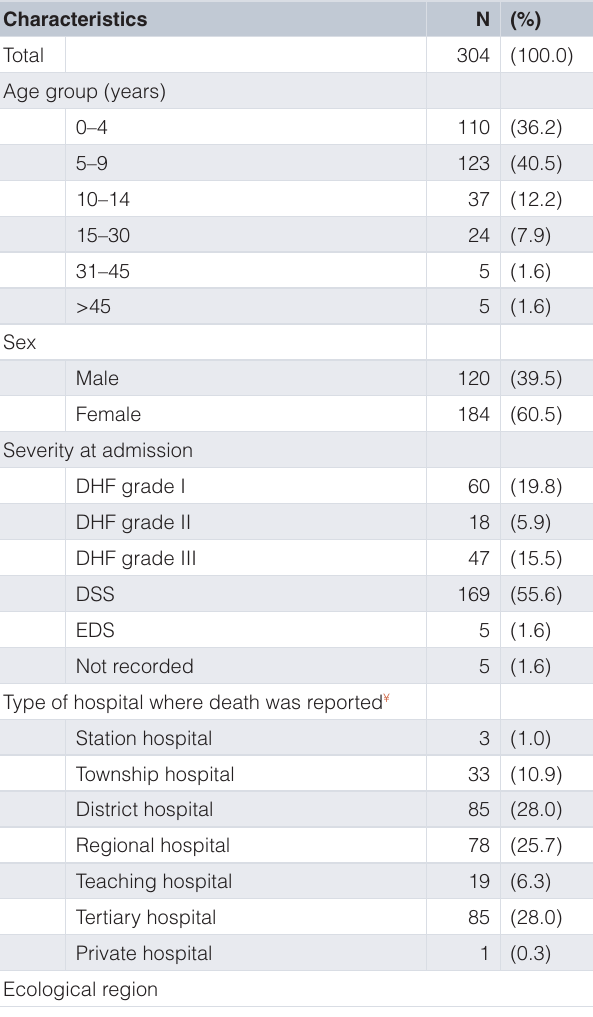
Table 2. Profile of dengue deaths reported to the national programme in Myanmar (2017–18).